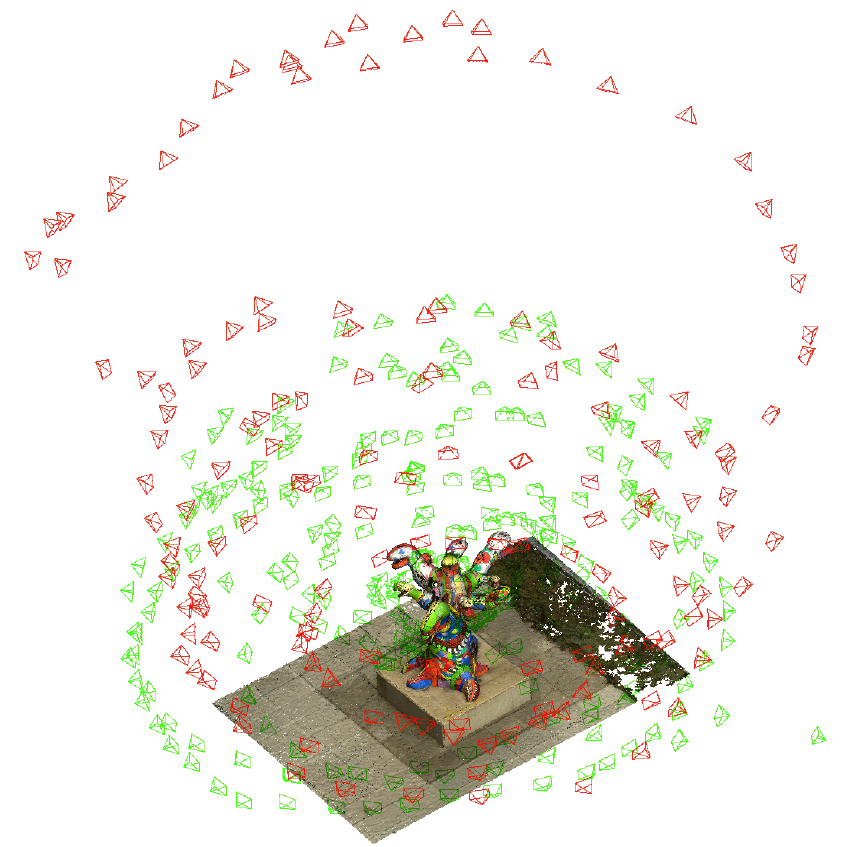
Figure 5. Arbre-Serpents dataset : fusion result of two UAV-based blocks of acquisition (before and after restoration).